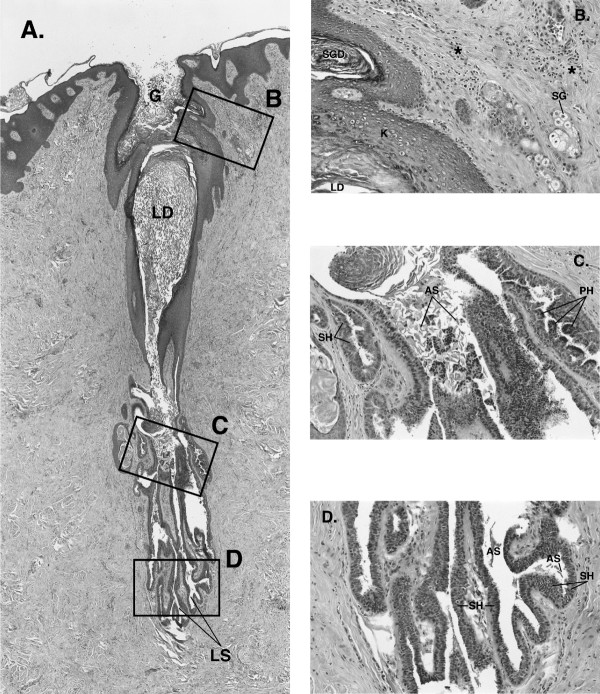
Histological features of the carcinomatous breast (magnification × 100). Detailed histology of (a) is seen in (b–d). AS, anucleate squames; asterisks, interstitial lymphocytic infiltrates; G, galactophore; K, keratin; LS, lactiferous sinus; LD, lactiferous duct; SG, sebaceous gland (tangenial cut); SGD, sweat gland duct; SH, simple epithelial hyperplasia; PH, papillary epithelial hyperplasia.